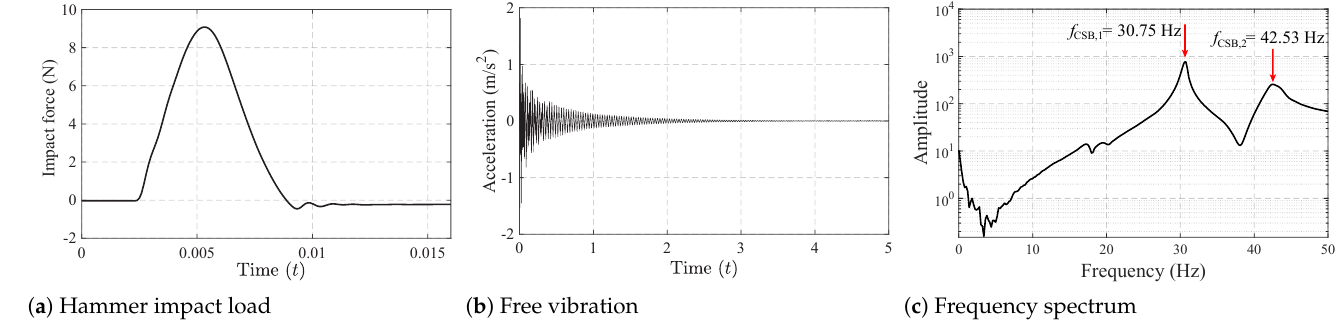
Figure 8. Free-vibration tests of the CSB model.